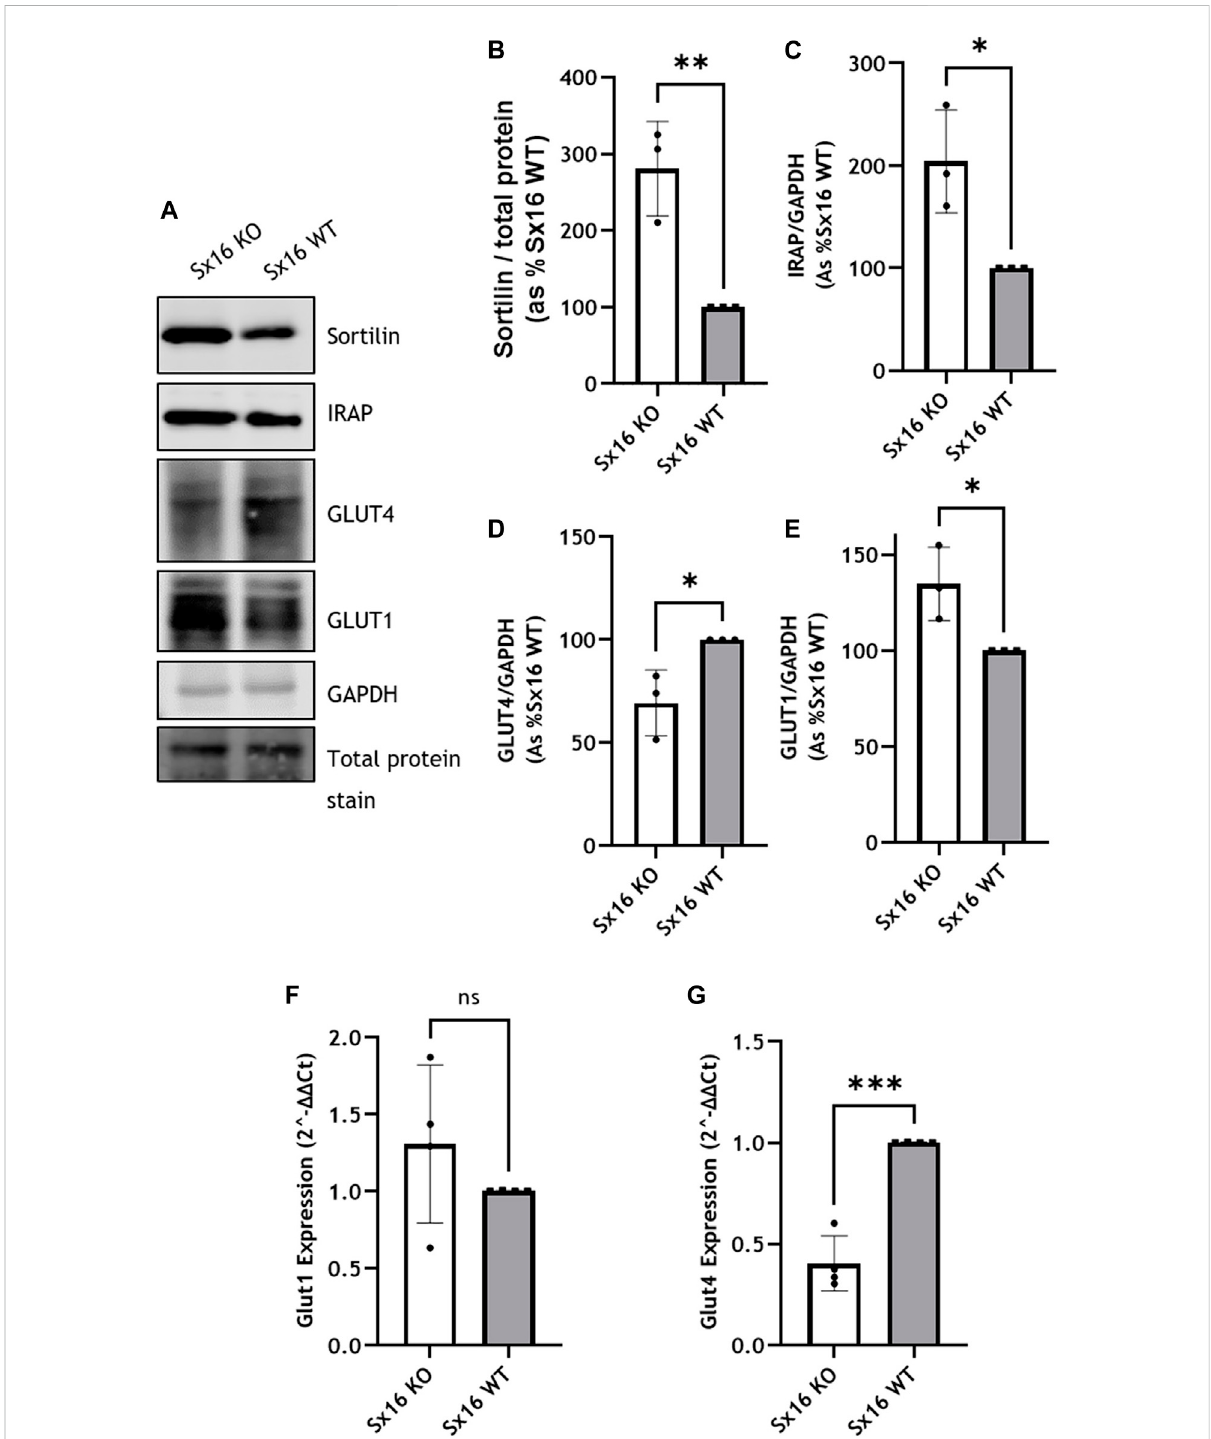
Glucose transporter expression in Sx16 knockout adipocytes. (A) Lysates prepared from Sx6 KO or WT cells were immunoblotted for the indicated proteins. Representative immunoblots of sortilin, insulin-regulated aminopeptidase (IRAP), glucose transporter 4 (GLUT4), GLUT1 and GAPDH are shown (B – E) . Quanti fi cation of Sortilin (B) , IRAP (C) , GLUT4 (D) or GLUT1 (E) were determined by comparison with GAPDH using densitometric analysis; data is from three biological replicates (mean ± SD, and each data point is shown (F,G) GLUT1 and GLUT4 gene expression was quanti fi ed using qPCR as outlined. Shown is the mean ± SD of four independent experiments in which the levels of GLUT4 and GLUT1 mRNA werequanti fi ed compared to hypoxanthine-guanine phosphoribosyl-transferase. Data ispresented as %relative to Sx16wild typecell lysate. * p < 0.05, ** p < 0.01 and *** p < 0.001 by Students t